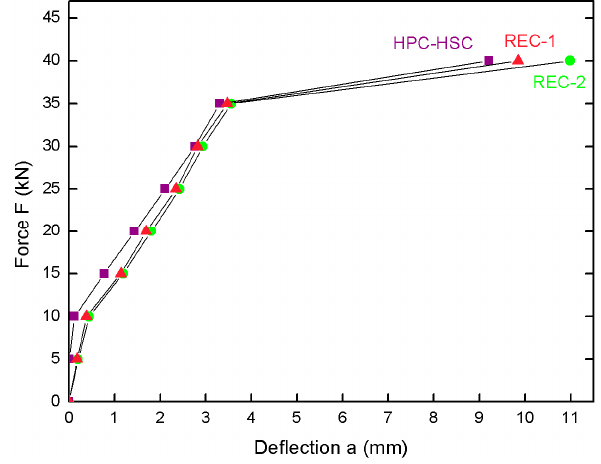
Figure 8. Correlation between force acting on the concrete samples and deflection.